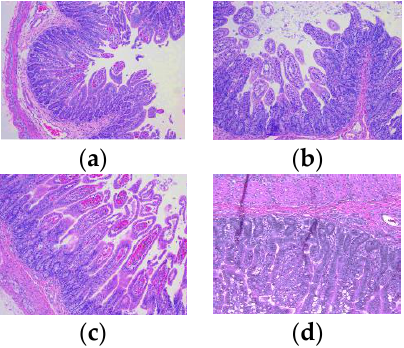
Figure 2. Hematoxylin and eosin-stained jejunal lesions in Gn pigs following oral inoculation with Arg P[6] HRV. All tissues were collected at necropsy on PID 2 or 3. ( A ) Villous damage with fibrin thrombi. ( B ) Atrophy of the enterocytes. ( C ) Hemorrhage is present in the lamina propria. ( D ) Nor-